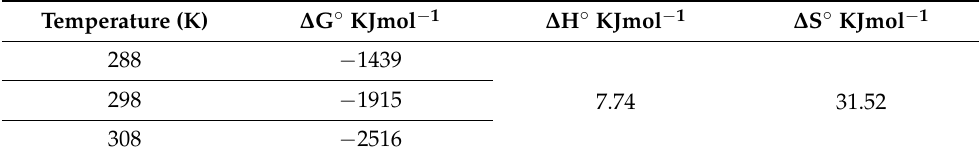
Table 4. Different thermodynamic parameters for AB-234 dye.